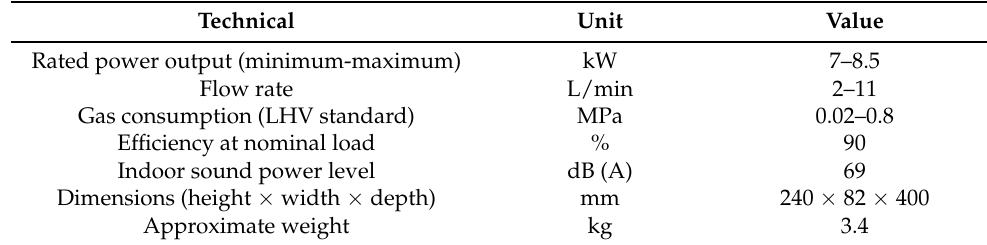
Table 1. The parameters of domestic gas-fired